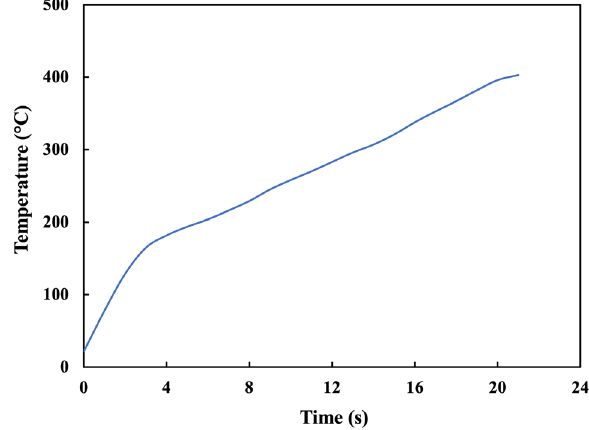
Fig. 2 Temperature versus time graph depicting the heating rate for compression test at 400